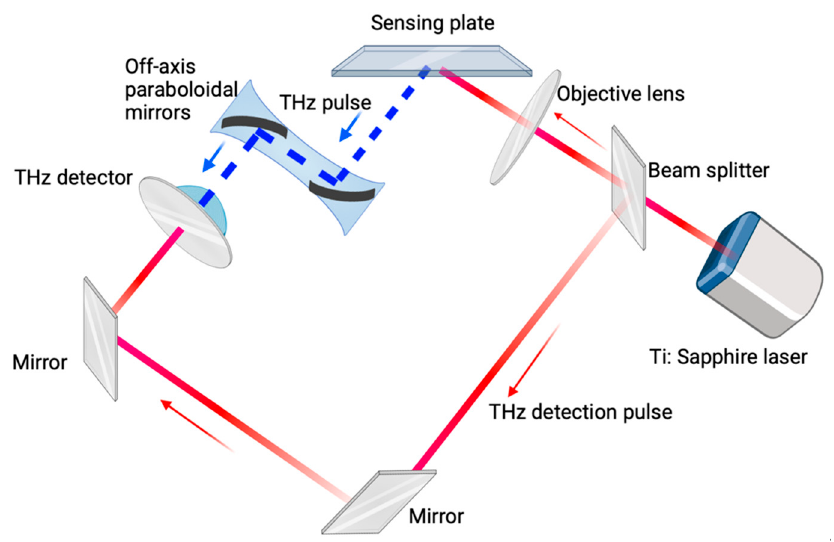
Figure 2. Schematic of the optical setup of the terahertz chemical microscope (TCM). Created with BioRender.com.